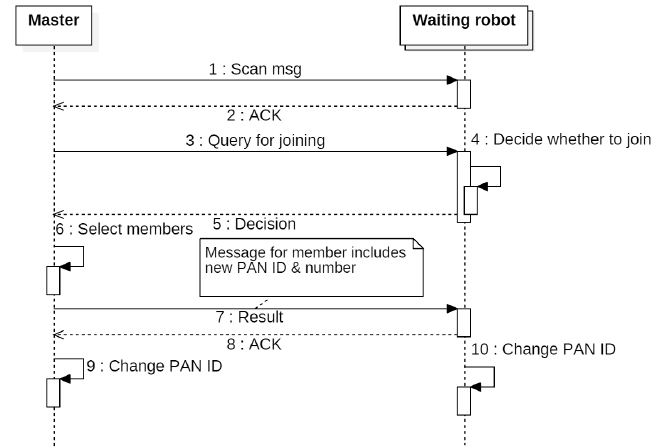
Figure 8. Sequence diagram of the process for organizing a swarm network.